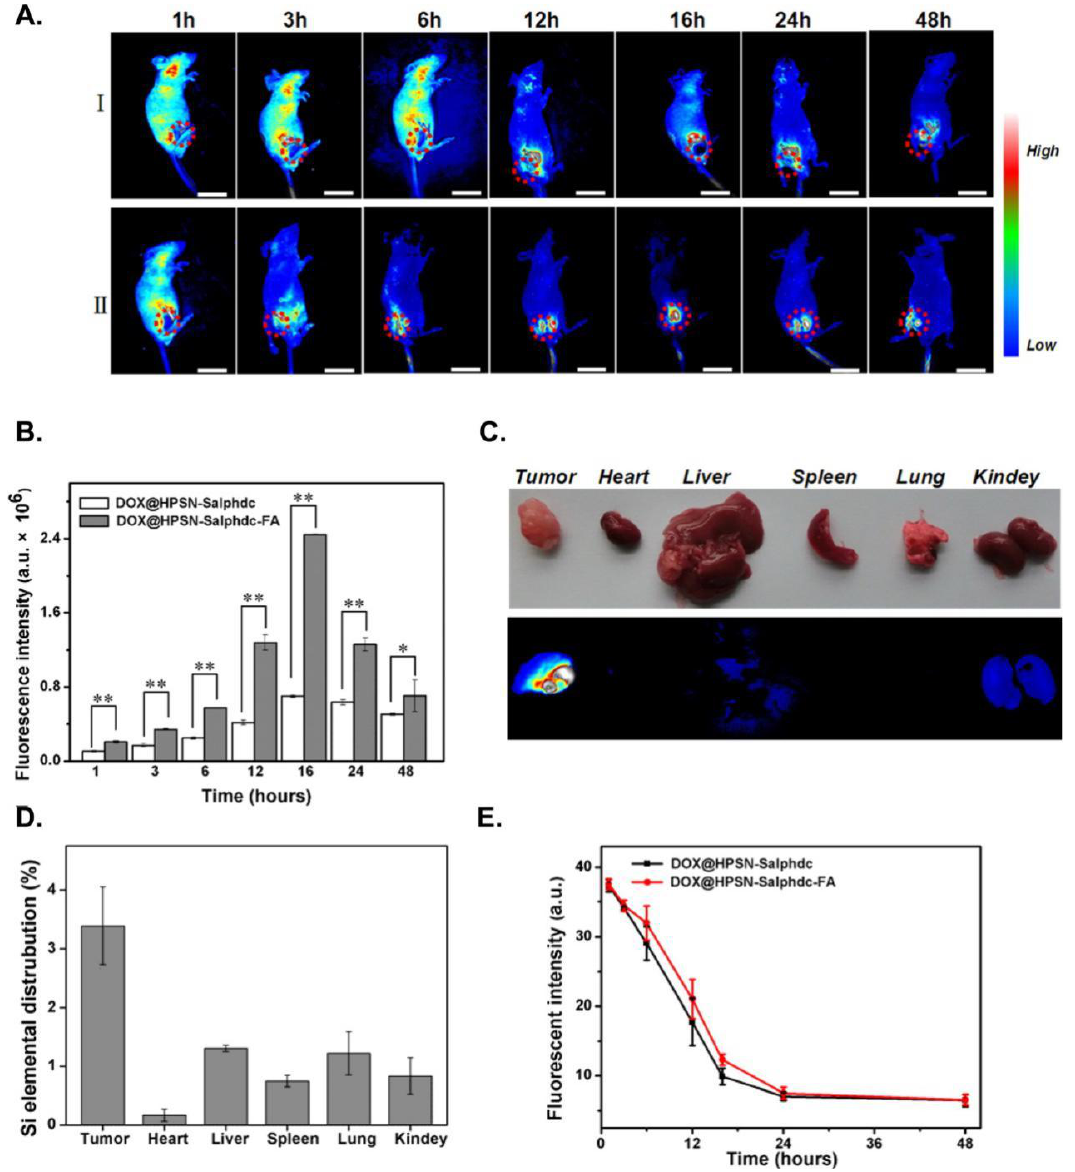
Figure 4. ( A ) Whole-body real-time fluorescence imaging of DOX@HPSN-Salphdc (I) and DOX@HPSN-Salphdc-FA (II) at different hours. Scale bars: 3 cm. ( B ) Histogram of the fluorescence intensity of tumors issue treated with Dox@HPSN-Salphdc and Dox@HPSN-Salphdc-FA at each interval, respectively. ( C ) Images of mainly organs and ( D ) quantitative energy dispersive spectrometry analysis after injection of DOX@HPSN-Salphdc-FA for 16 h. ( E ) The fluorescence intensities of both nanoparticles in blood over time. The error bars indicate the mean ± SD ( n = 4). * p < 0.05 and ** p < 0.01. Reproduced with permission from [39]. Copyright 2015 American Chemical Society.